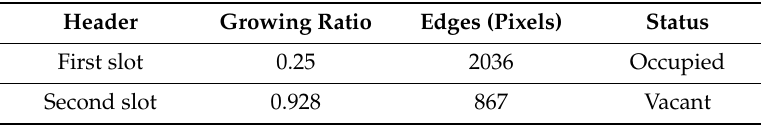
Table 4. Parking space features for urban roadside parking